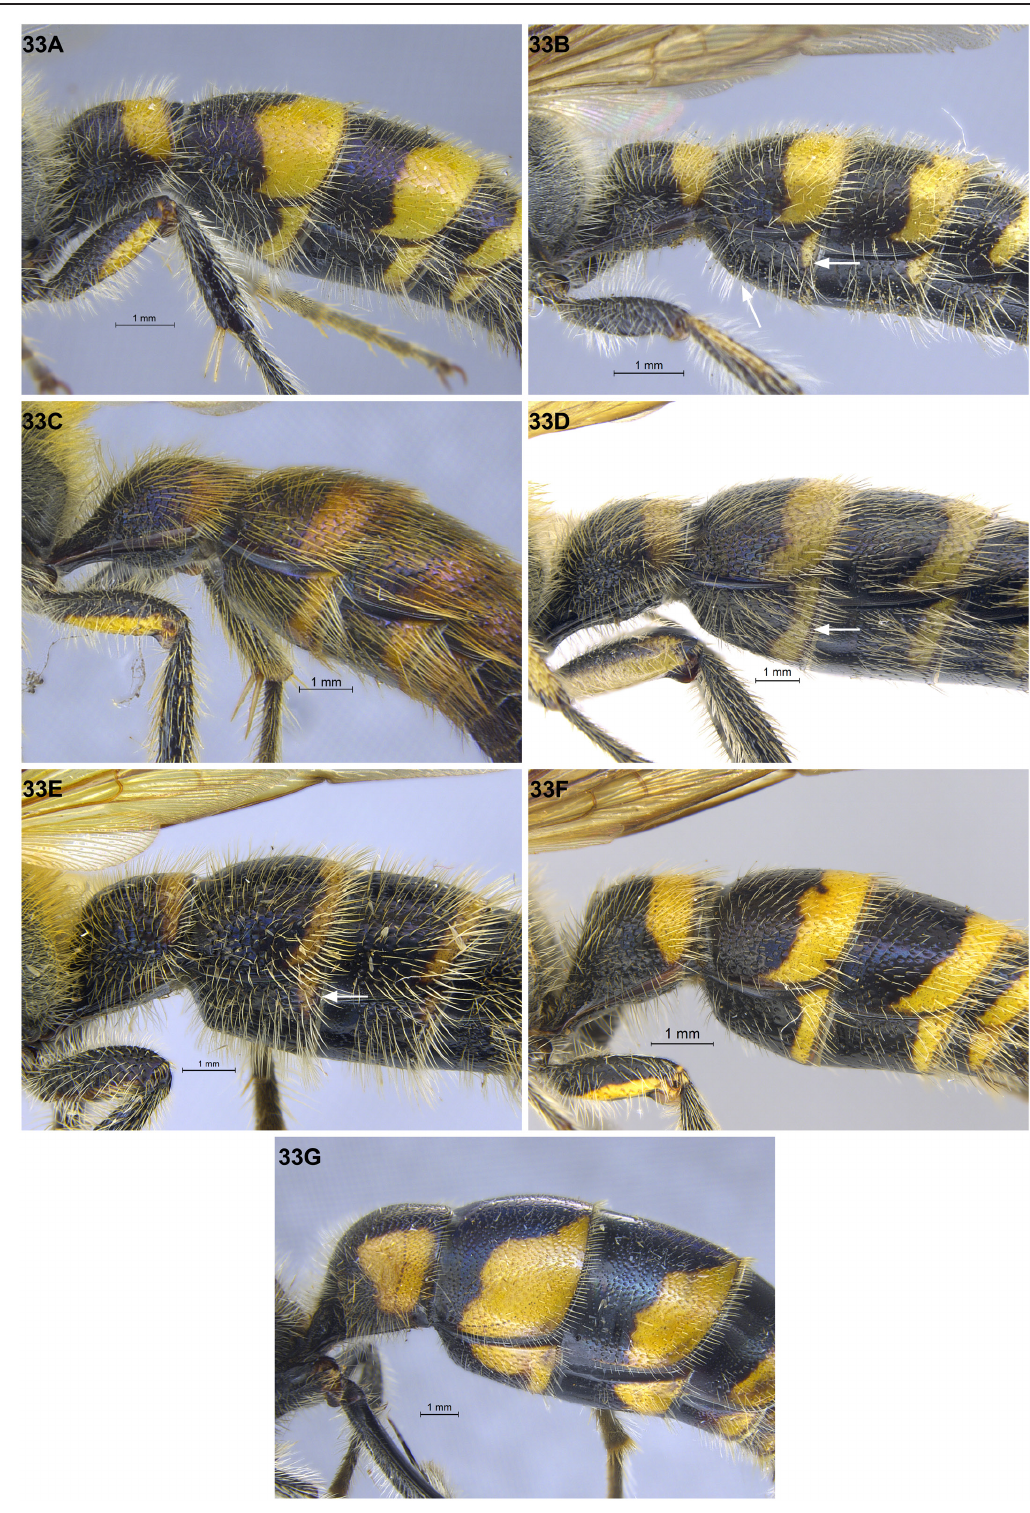
Fig. 33. Males, T1–T3, lateral view. A . Campsomeriella annulata annulata (Fabricius, 1793). B . Camps. collaris (Fabricius, 1775). C . Megacampsomeris sp. 1. D . Megacam. formosensis chinensis Betrem, 1941. E . Megacam. prismatica (Smith, 1855). F . Phalerimeris phalerata phalerata (de Saussure, 1858). G . Sericocampsomeris flavomaculata Gupta & Jonathan,